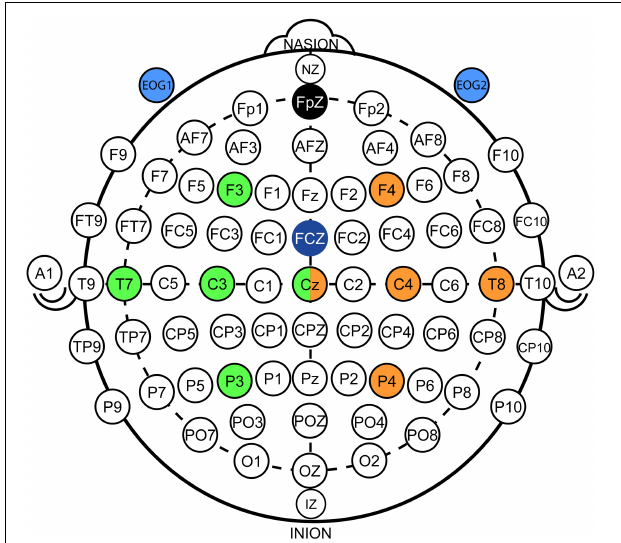
FIGURE 1 | Electroencephalography/electrooculography (EEG/EOG) electrode setup. EEG setup: Nine conventional EEG recording sites were used in accordance to the international 10/20 system. Five electrodes on each hemisphere were applied that were centered around C3 (green color coding) and C4 (orange color coding). Signals from Cz were used for both hemispheres. EOG setup: Two EOG electrodes (light blue color coding) were placed laterally of the outer canthi of the left and right eye to assess horizontal oculoversions (HOVs) based on the bipolar EOG signal (i.e., difference between EOG1 and EOG2). Ground and reference electrodes were placed at Fpz (black color coding) and FCz (dark blue color coding),